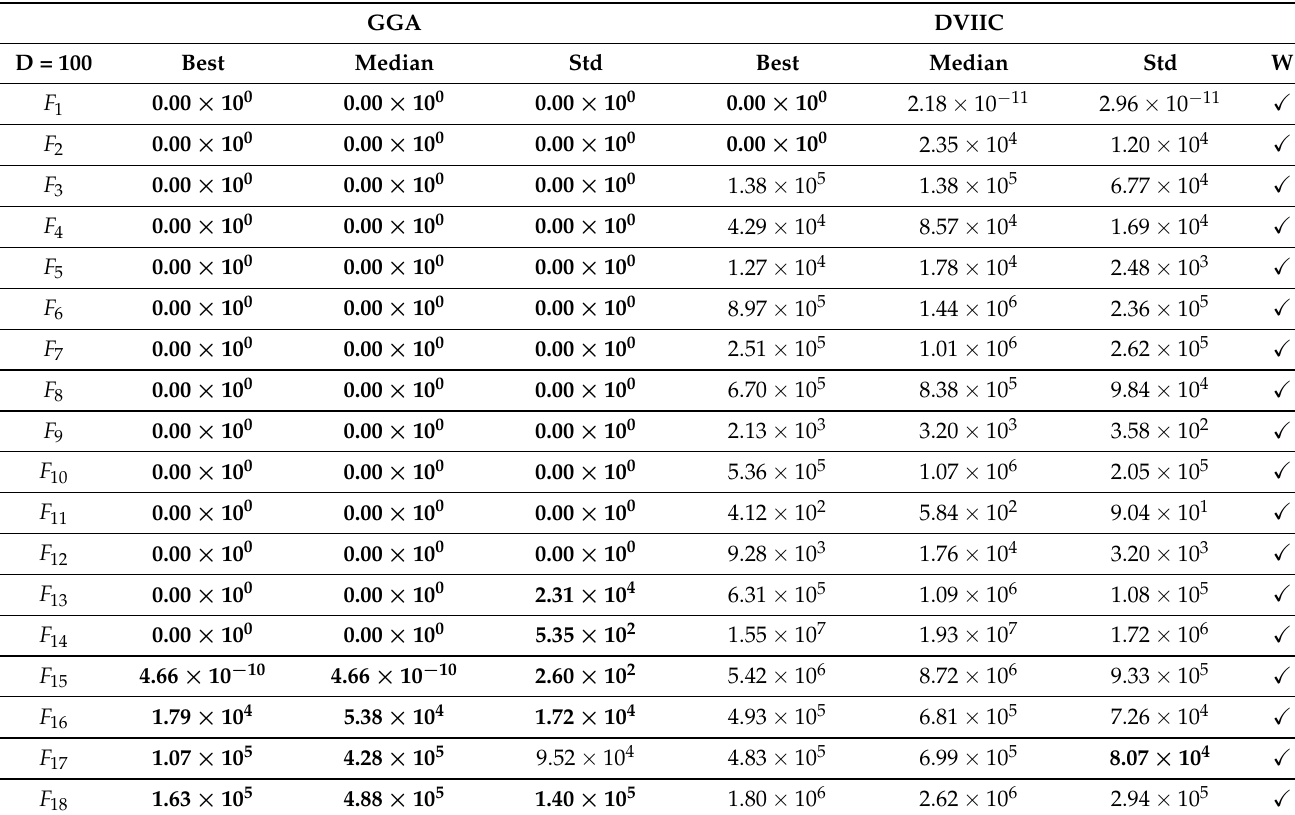
Table 3. Statistical results in dimension 100. Best results shown in boldface.